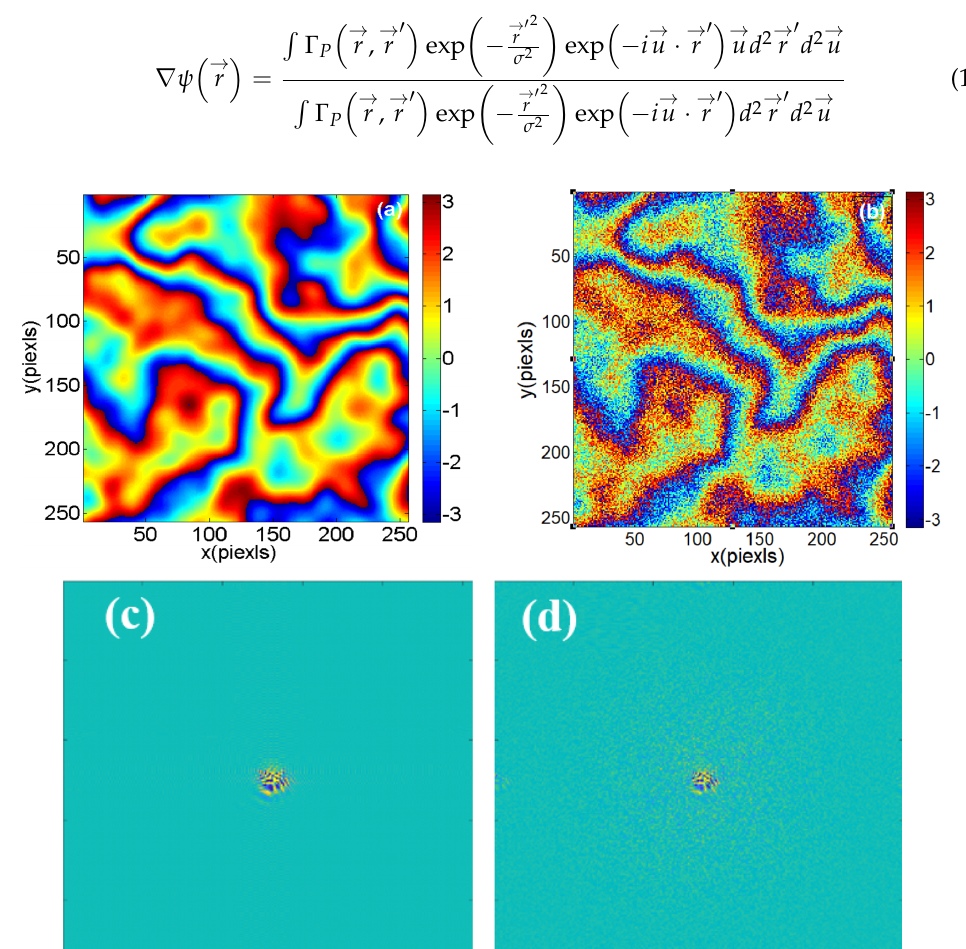
Figure 2. The comparison of the Wigner distribution function (WDF) in the initial and noised phase map. ( a ) The initial wrapped phase map with size 256 × 256, ( b ) the noised wrapped phase map with uniform noise in the range of [−0.5π, 0.5π], ( c ) the frequency distribution at coordinates (184, 65) of ( a ), and ( d ) the frequency distribution at the coordinates (184,65) of ( b ).